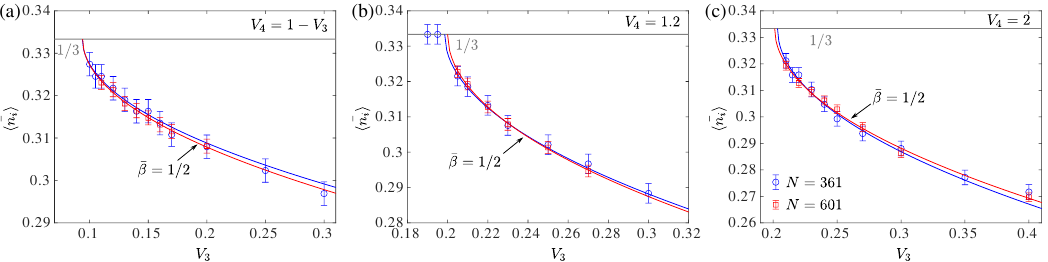
Figure 7: Average density ¯ n as a function of coupling constant V = 1 − V cut V , and two horizontal cuts along (b) V 4 3 lines are results of the fit ∝ | V and Pokrovsky-Talapov critical exponent ¯ β = 1 /